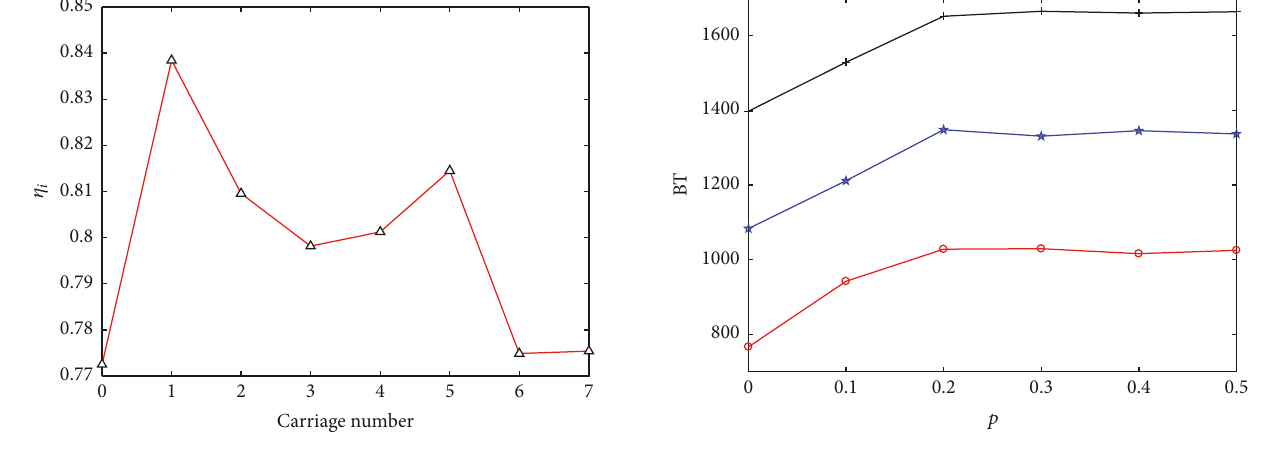
Figure 11: The passengers’ average movement efficiency of each carriage.